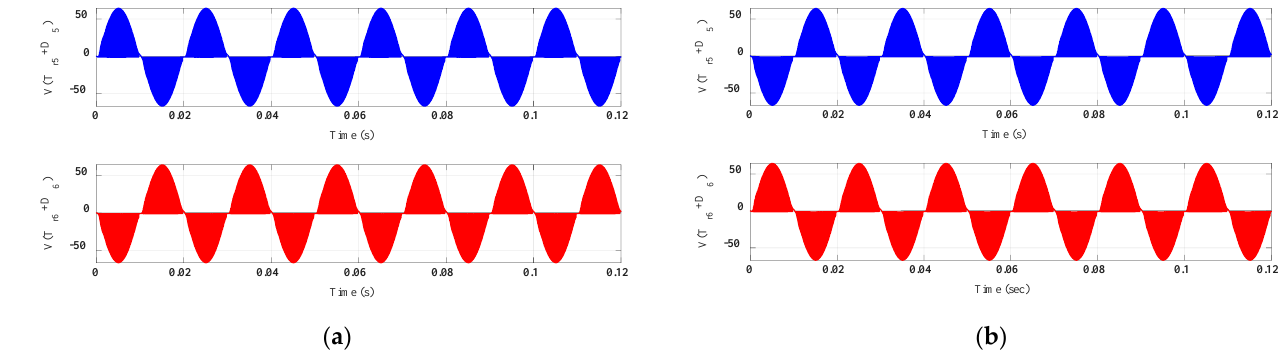
Figure 12. Computer simulation results for output step-up process across T r 5 , D 5 (blue) and T r 6 , D 6 (red) in ( a ) non-inverted form and ( b ) inverted form.